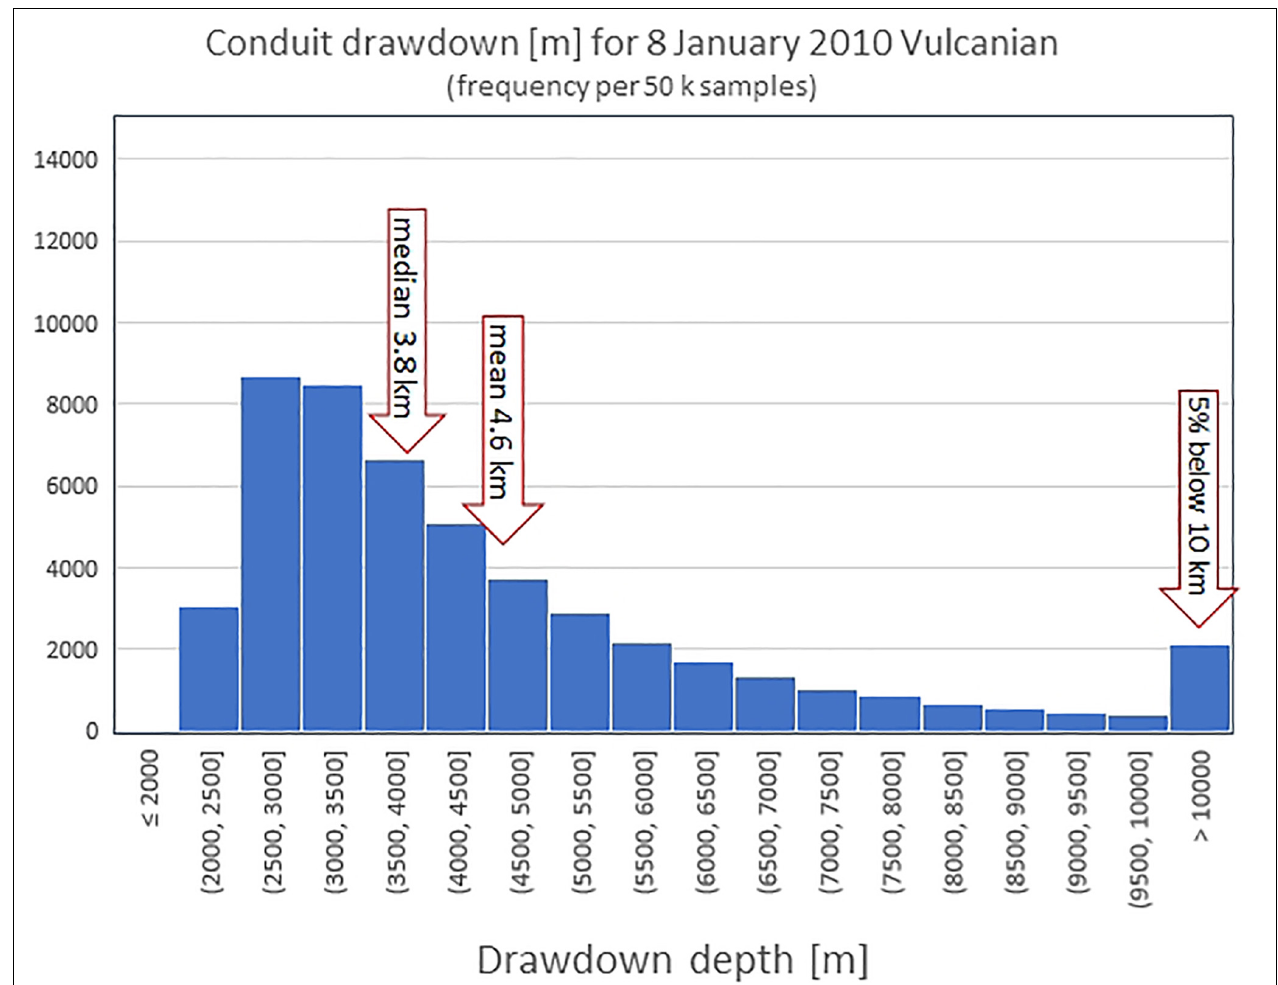
FIGURE 5 | The largest Montserrat explosion: January 8, 2010. Uncertainty distribution for drawdown depth (a total of 50,000 Monte Carlo samples are distributed into the depth ranges shown on the x -axis). The top of the upper reservoir is assumed at an approximate depth of 5 km (following Thomas et al.,